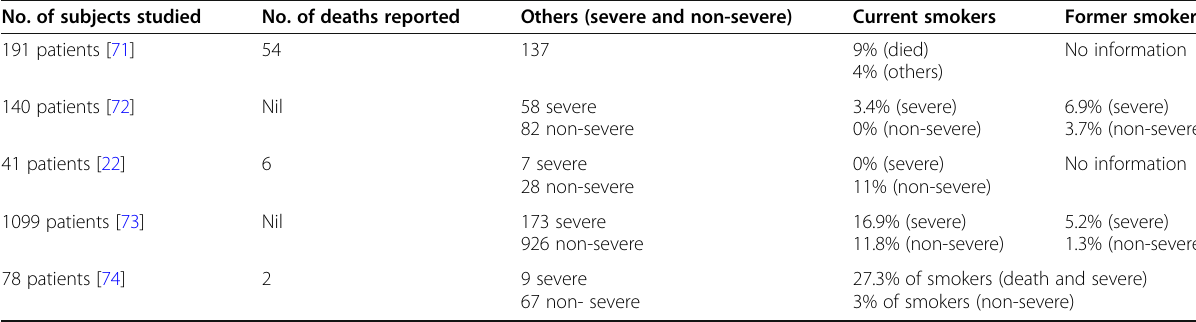
Table 1 Smoking status of COVID-19 patients No. of subjects studied No. of deaths